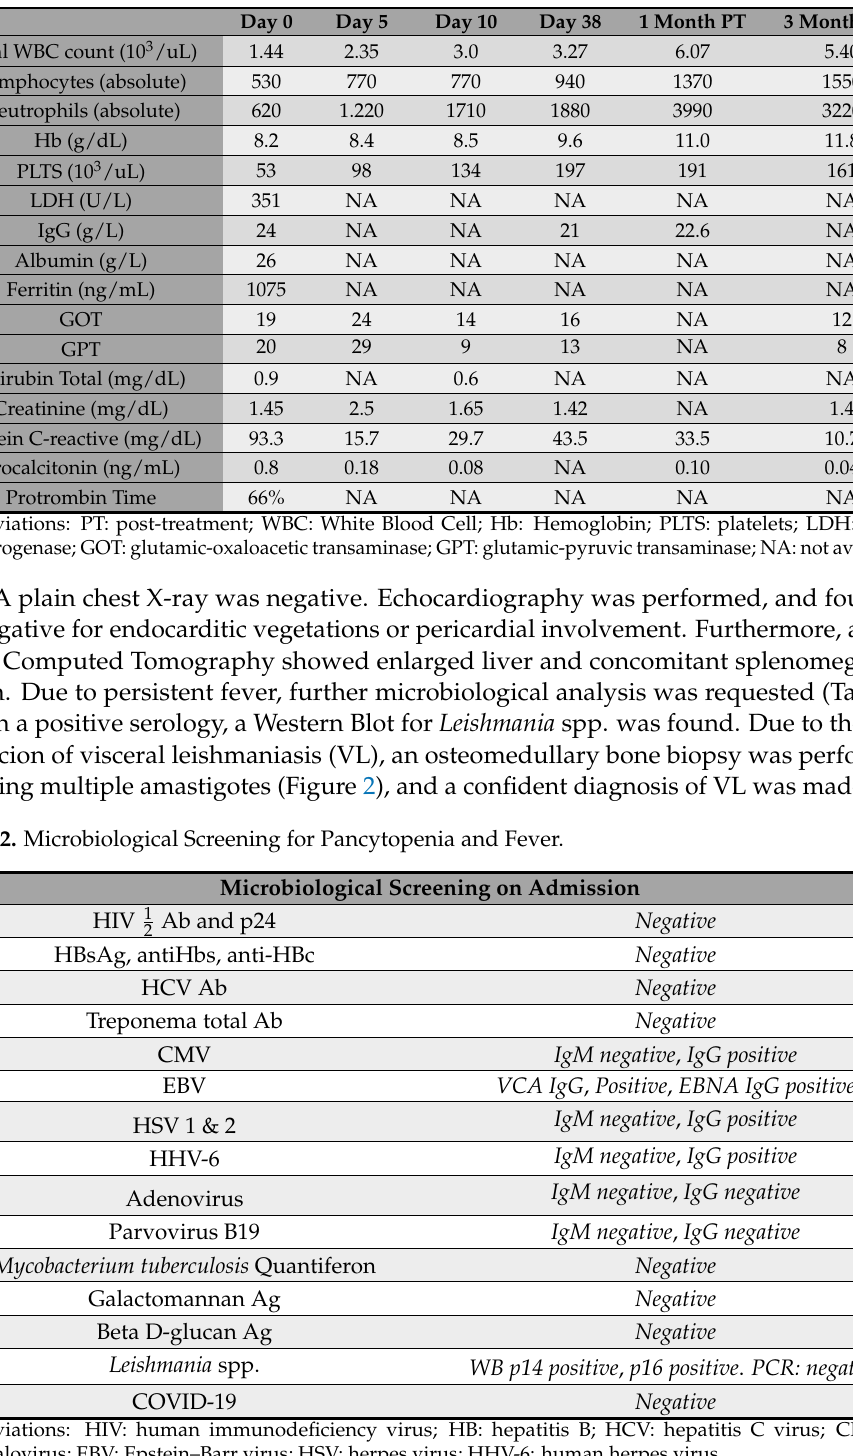
Table 1. Timeline from admission to first 3-month follow-up.